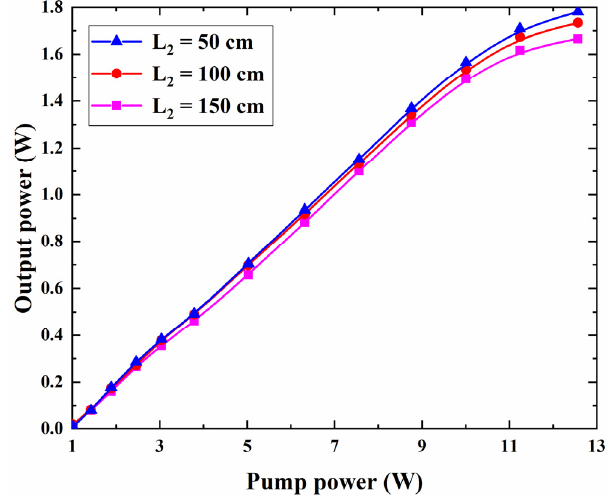
Figure 7. VECSEL output power curves for different external cavity lengths at 0 °C.